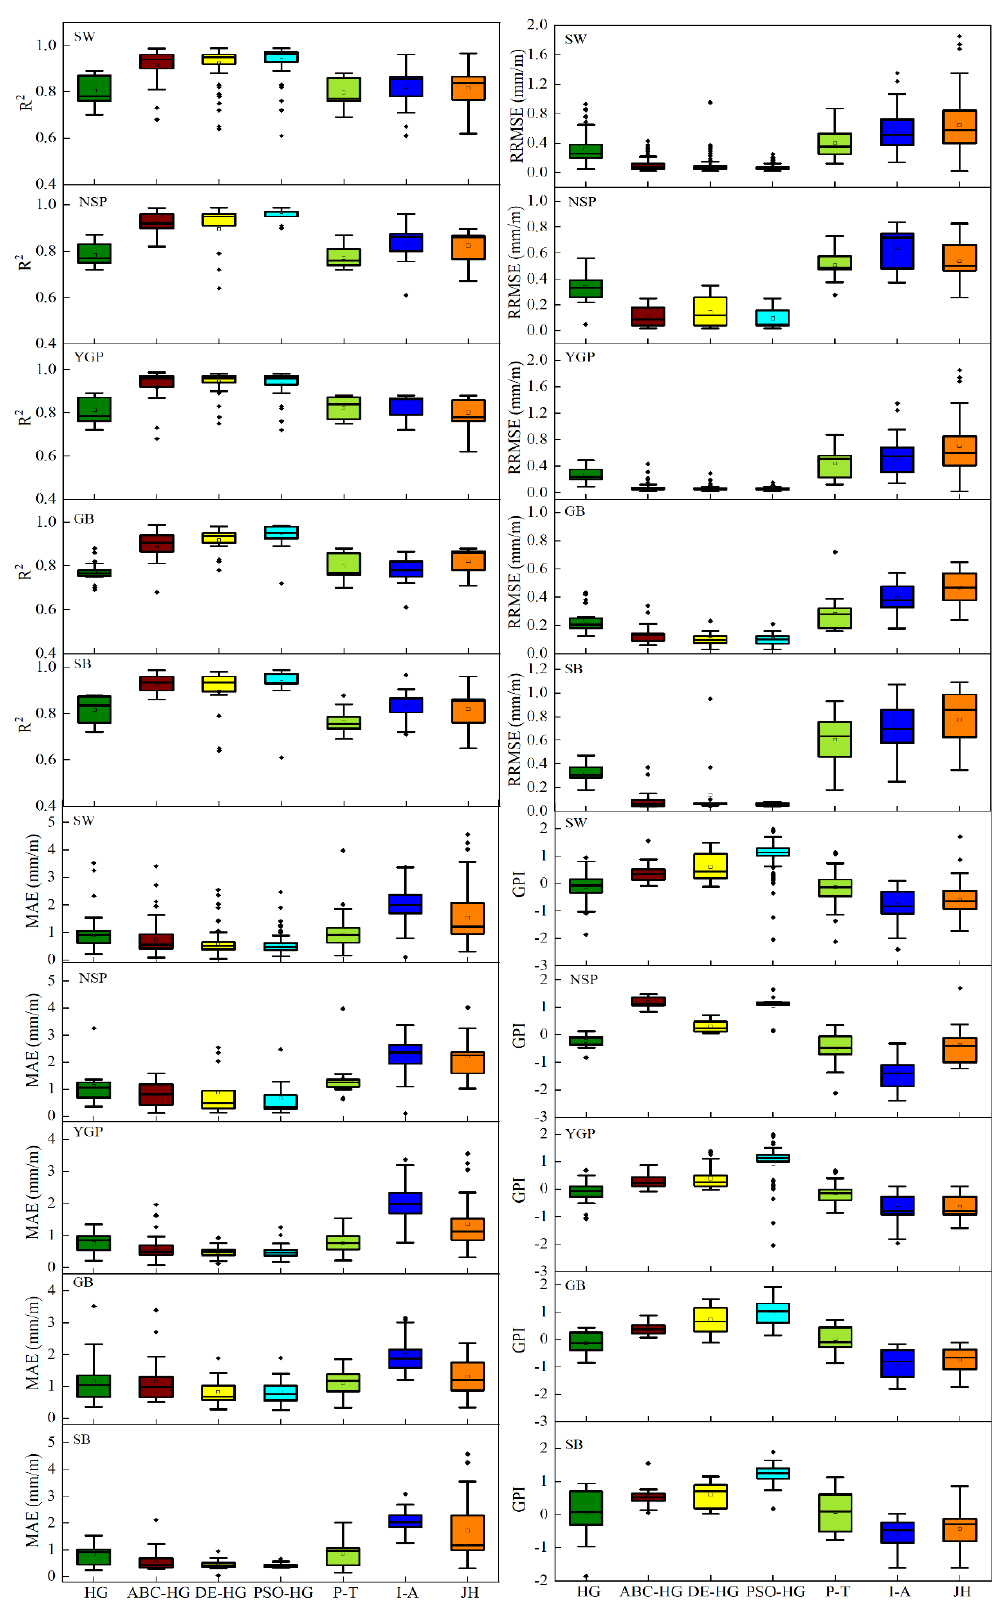
Figure 6. Estimated monthly ET 0 accuracy in Southwest China and 4 districts based on HG model calibrated by ABC, DE, and PSO algorithms and 4 empirical models. Note: HG, PT, IA and JH represent Hargreaves, Priestley–Taylor, Imark–Allen and Jensen–Hais. NSP: Northwest Sichuan Plateau; GB: Guangxi Basin; SB: Sichuan Basin; YGP: Yunnan–Guizhou Plateau.